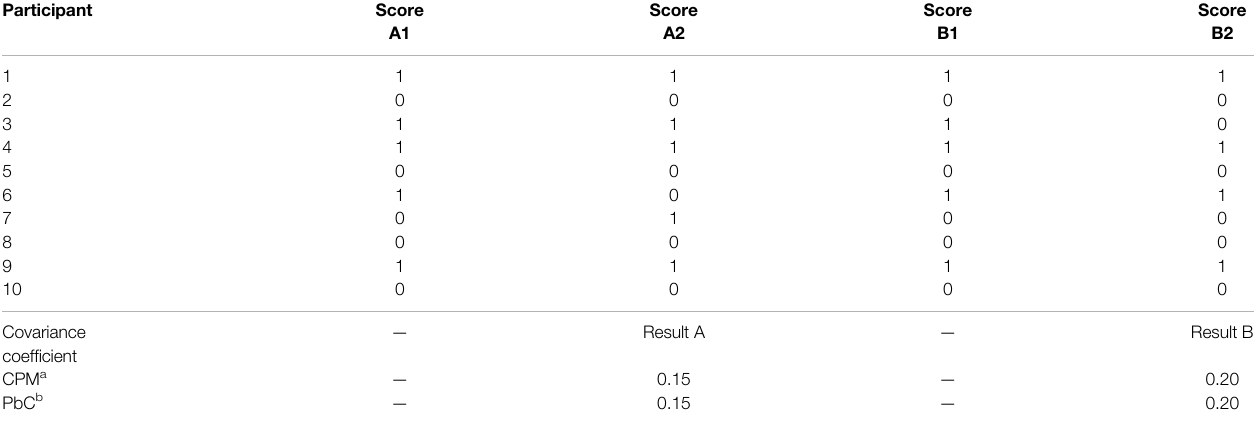
TABLE 1 | Example Data Together With the Covariances Computed Using Product-moments (CPM) and Probabilities (PbC).